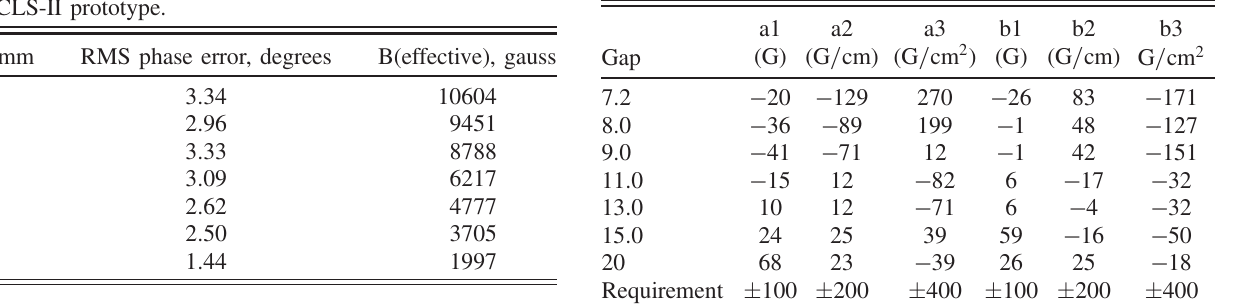
TABLE V. LCLS-II integrated multipole